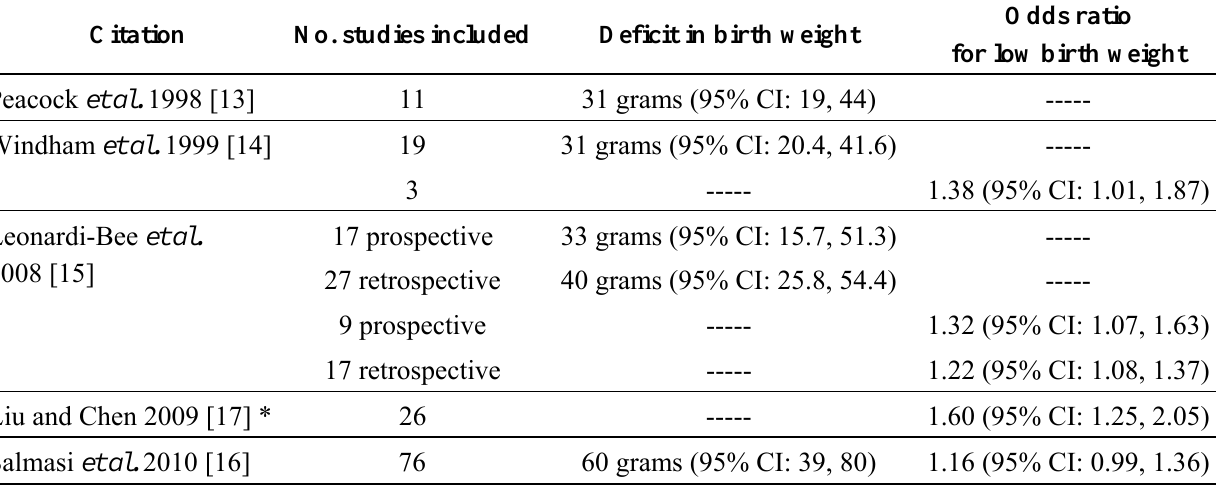
Table 1. Meta-analyses of the impact of prenatal SHS exposure on infant birth